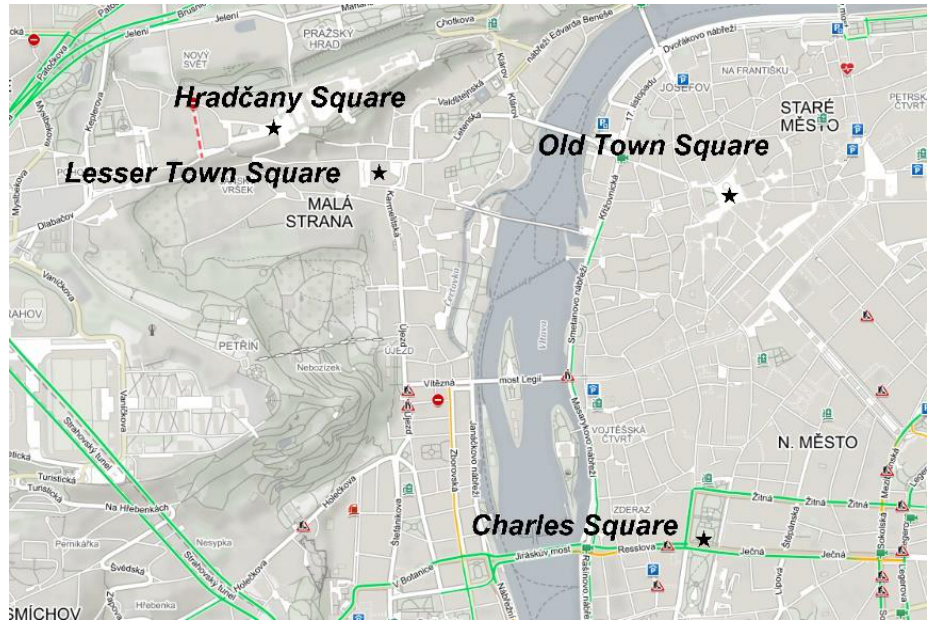
Figure 1. The historical center of Prague with position of studied areas (squares).